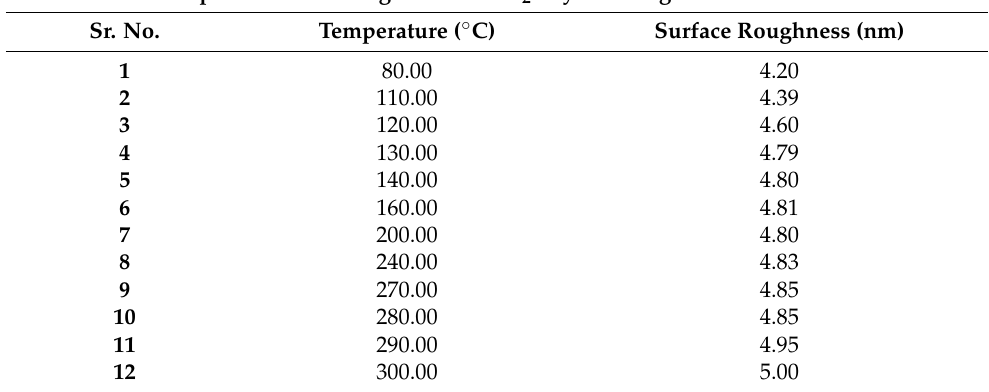
Table 2. The change in surface roughness against the variation in the temperature using the PECVD process for the S i O 2 layer deposition.